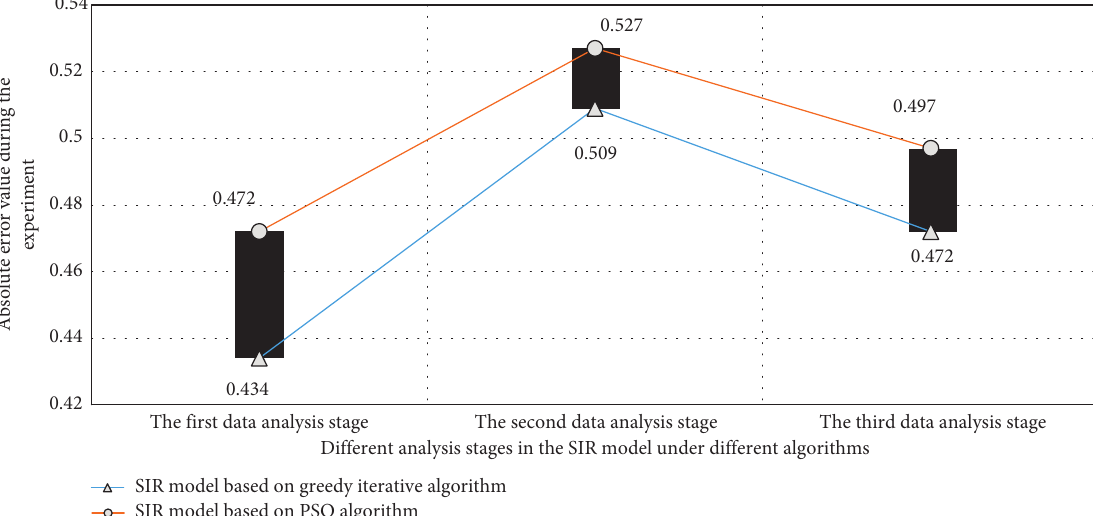
Figure 8: The absolute error values corresponding to different analysis stages in the SIR model under different algorithms.